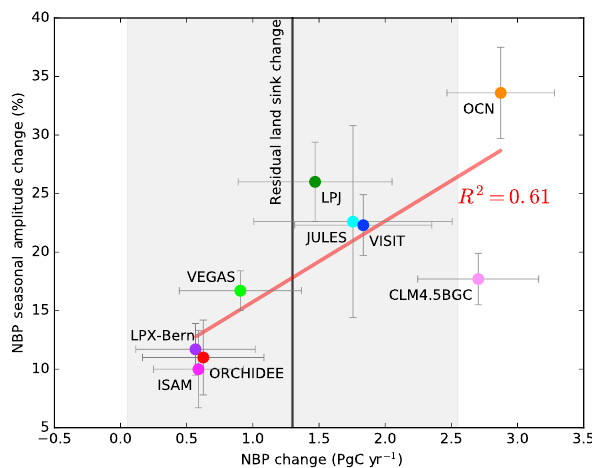
r Figure 10. Relationship between the increase in net biosphere pro- duction (NBP, equal to − F TA ) and increase in NBP seasonal am- plitude (as in Fig. 4’s red dots), for the 1961–2012 period for nine TRENDY models. Error bars indicate the standard errors of the trend estimates. Increase in residual land sink is estimated by tak- ing the difference between two residual land sinks, over 2004–2013 and 1960–1969 (an interval of 44 years), as reported in Le Quéré et al. (2015). This difference is then scaled by 52 / 44 (to make it comparable with models’ NBP change for this figure), which is dis- played by a black vertical line and shading (error added in quadra- ture, assuming Gaussian error for the two decadal residual land sinks, then also scaled). The cross-model correlation ( R 2 = 0.61, p <0.05) suggests that a model with a larger net carbon sink in- crease is likely to simulate a higher increase in NBP seasonal am-